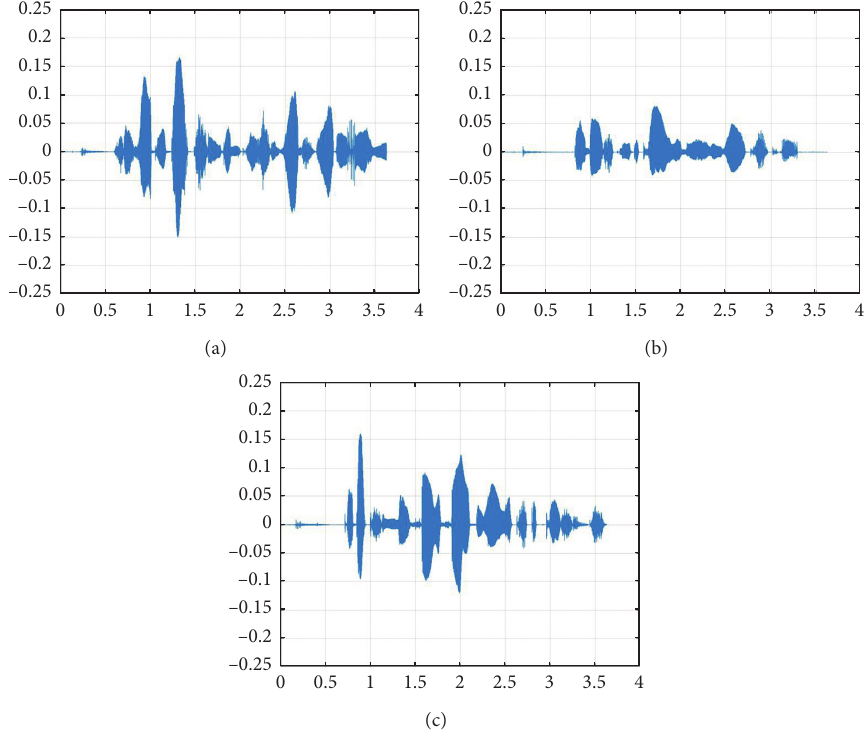
Figure 15: Time-domain waveform diagram of speech signal extraction under quantum chaos: (a) SA1 speech signal; (b) SA2 speech signal; (c) SI943 speech signal.